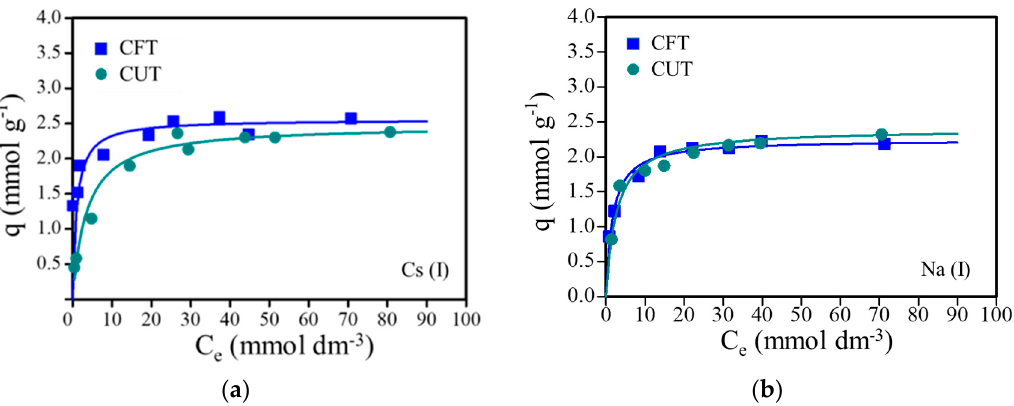
Figure 6. Adsorption isotherms: ( a ) Cs + ion on crosslinked fresh tea leaves (CFT) and crosslinked used tea leaves (CUT) adsorbents, ( b ) Na + ion on CFT and CUT adsorbents, adsorbent weight = 0.05 g, solution volume = 10.0 cm 3 , pH e = 7.0 ± 1.0 (Cs + ) and 7.5 ± 0.5 (Na + ), shaking time = 24 h.